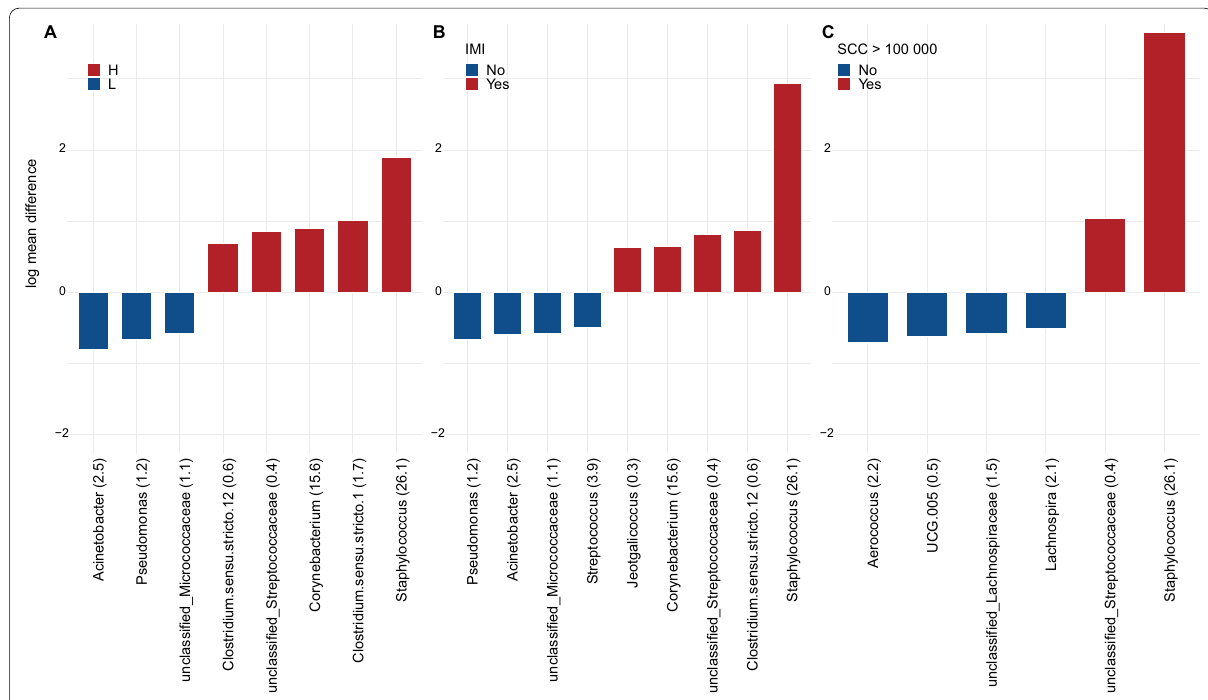
Fig. 3 Differential abundance of the statistically significant general ( p < 0.05) plotted for A H- and L-cows, B presence of intramammary infection (according to definition “ A ” by Dohoo et al. [23]) and C somatic cell count (lower or greater than 100,000 SCC/mL) during sampling. Numbers in parenthesis after the genus names indicate the genus percentage of total